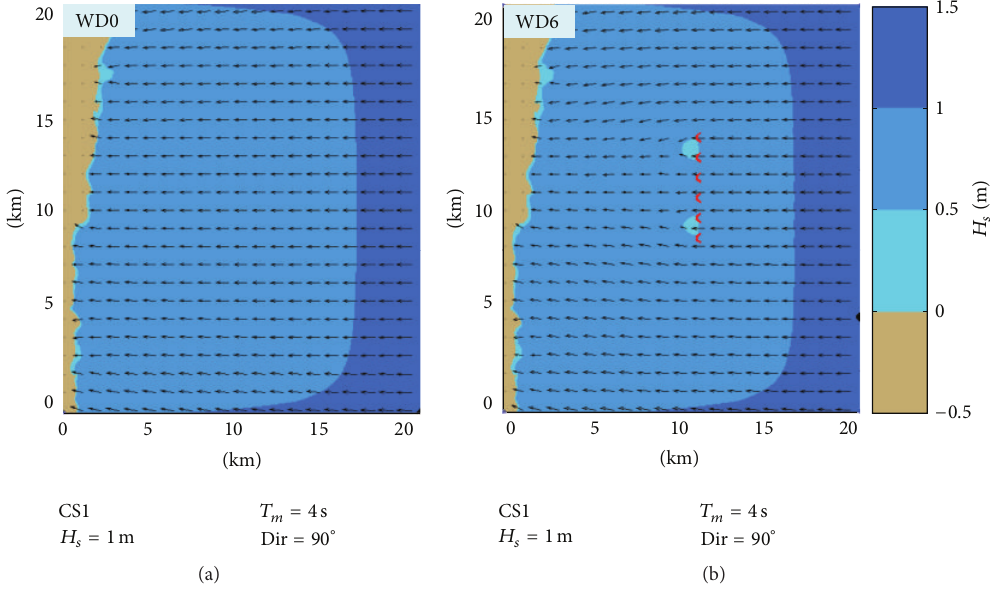
Figure 6: Evaluation in the geographical space of the impact on the wave field of a wave farm based on Wave Dragon WECs that operate in the target area. CS1—average to high energetic conditions and waves coming from east ( 90 ∘ in nautical convention). (a) SWAN simulation in the case without Wave Dragons (WD0). (b) SWAN simulation in the case when six Wave Dragons operate in line (WD6). The 𝐻 𝑠 scalar fields are presented in the background while in the foreground the wave vectors are